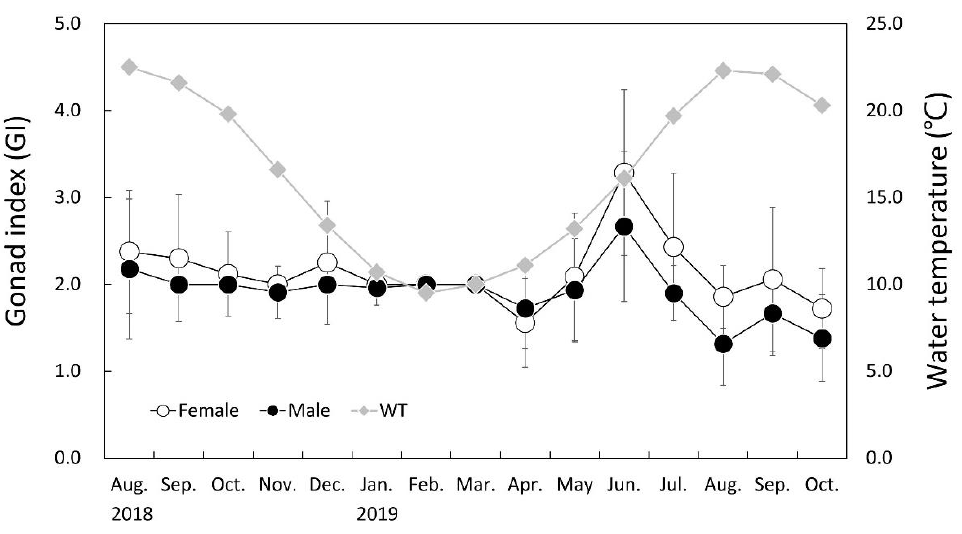
Figure 9. Monthly variations of gonad index (GI) in Buccinum osagawai . WT: water temperature. Vertical bars indicate SD.